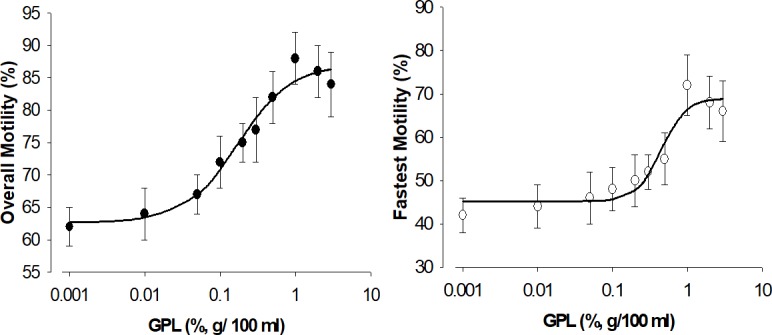
Dose response curves of overall and fastest sperm motility versus concentration of GPL.Both types of velocities are increased by incubation of sperm with sub-μm-sized micelles prepared from GPL. The solid line represents the best fit of a Hill equation. The effect is more pronounced (IC50 of approximately 0.5%) for the fastest sperm (right) compared with 0.15% for the overall motile sperm (left).